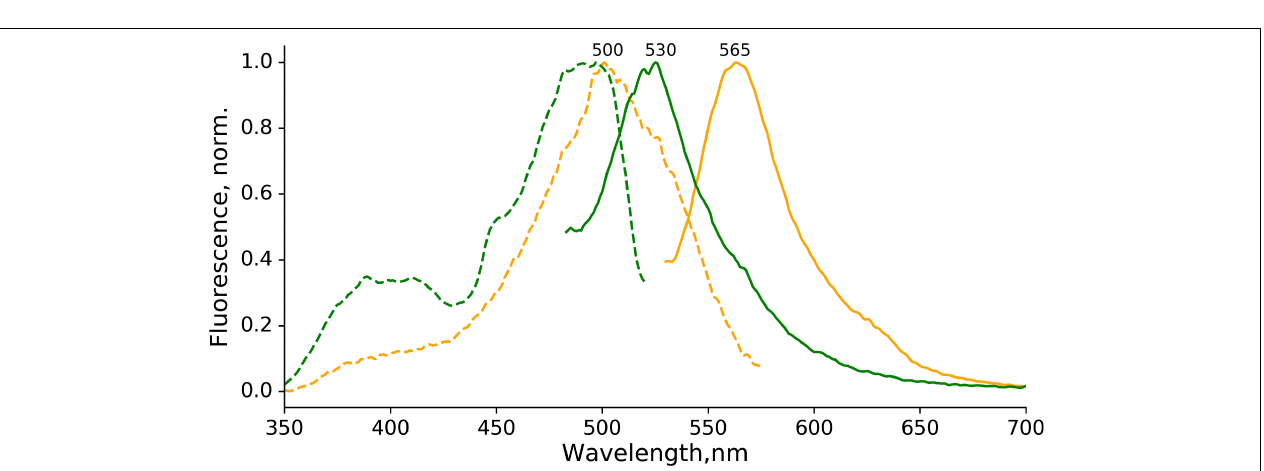
FIGURE 4 | Fluorescence decay kinetics of the EGFP photoproducts. (A) Photoconversion in the presence of potassium ferricyanide; (B,C) photoconversion in the presence of sodium dithionite. Repetition rate of pulsed light sources: 50 MHz (A) and 10 MHz (B,C) .